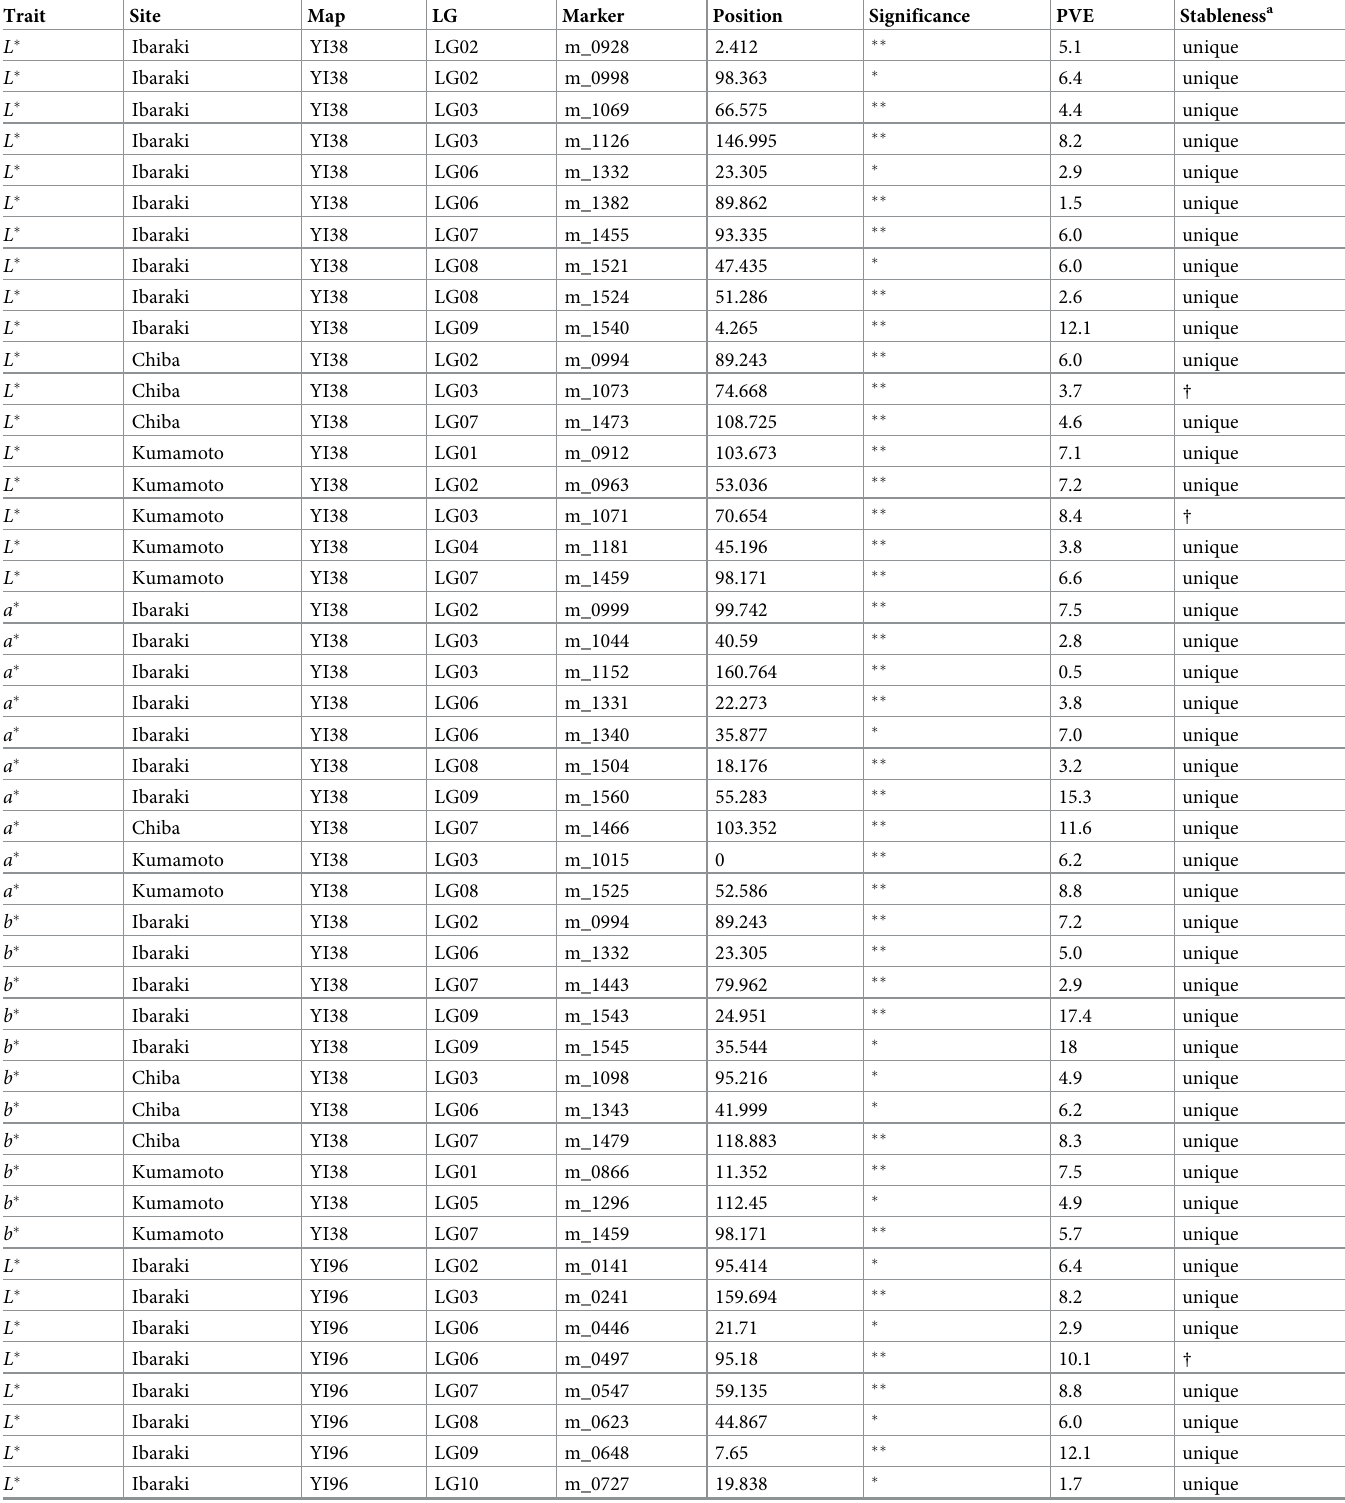
Table 3. List of QTLs identified for heartwood color traits ( L � , a � , and b � ) in the three sites.